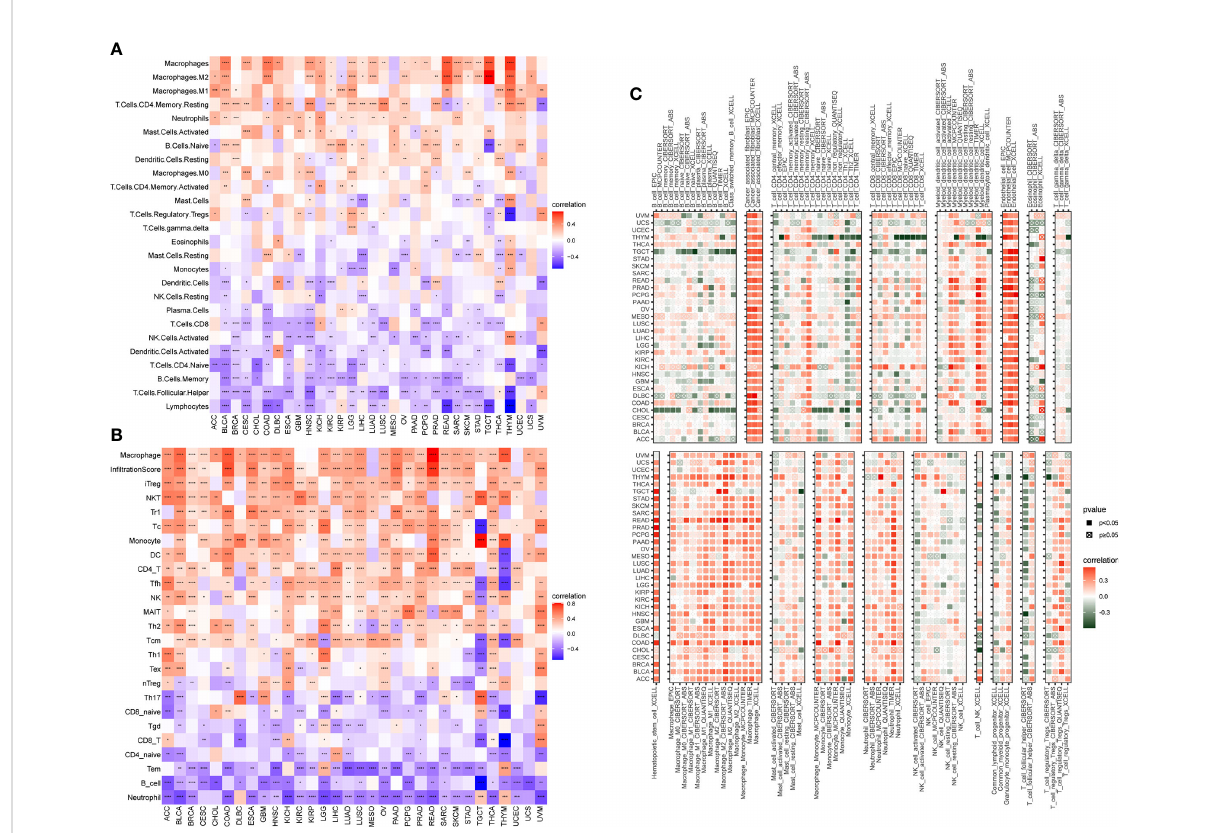
FIGURE 7 Association of the AR score with immune cell in fi ltration. Correlation between the AR score and immune cell in fi ltration based on published work (A) , ImmuCellAI database (B) and TIMER2 database (C) . The red and blue/green colors represent positive and negative correlations, respectively. *P < 0.05, **P < 0.01, ***P < 0.001, ****P <